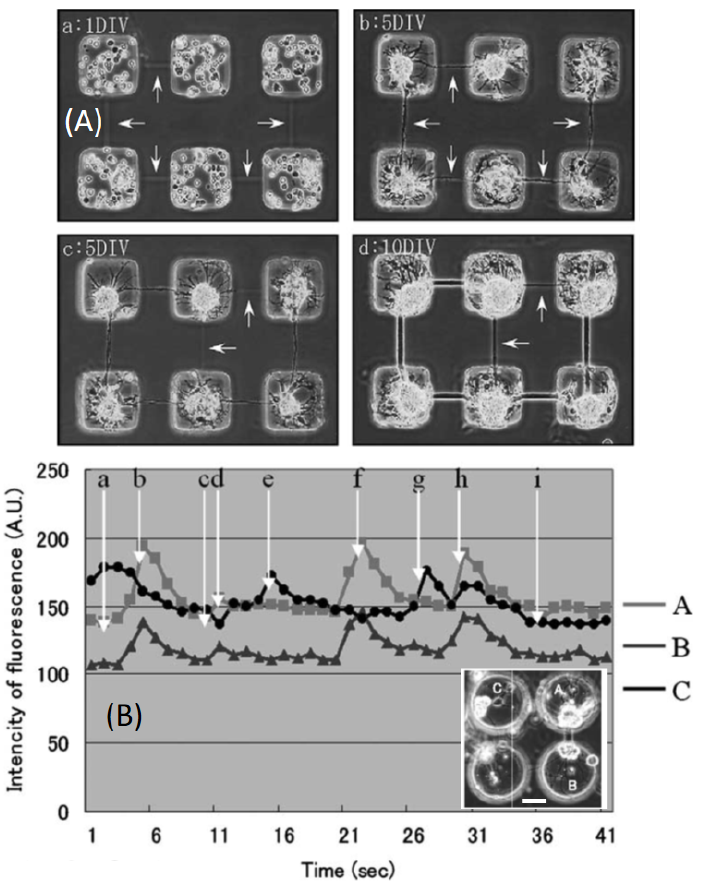
Figure 6. ( A ): example of the effect of photothermal etching during hippocampal cell cultivation. (a) and (b) compare situations immediately after photothermal etching and 5 days after the treatment, when (c) a new tunnel (white arrow) was photothermally created between agarose microchambers, leading, after another 5 days (d), to new neurites connecting cells through the newly added tunnel. ( B ): time dependence of Ca fluorescent signals from neural cells. Lines A, B, and C indicate the signals of the corresponding cells/microchambers in the image inset. Adapted and reprinted with permission from [36].